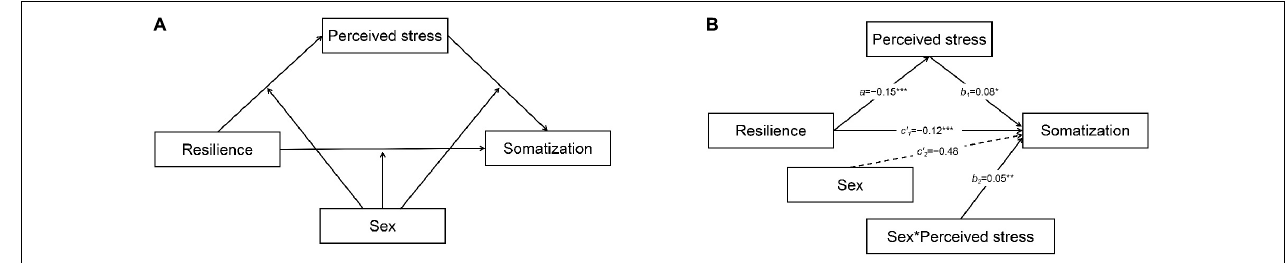
FIGURE 1 | (A) Conditional process model of sex on the link between resilience and somatization through perceived stress in conceptual form. (B) Conditional process model of sex on the link between resilience and somatization through perceived stress. Dashed lines indicated that statistically insignificant paths between variables. Solid lines indicated that statistically significant paths between